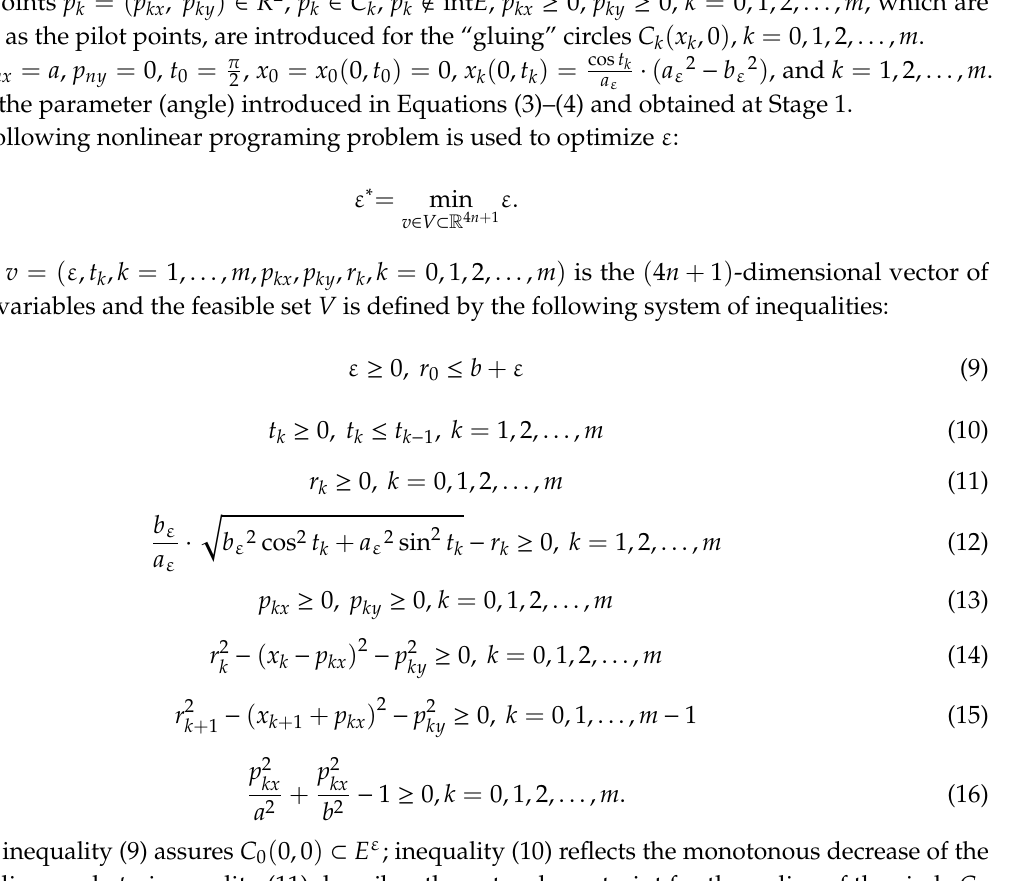
Figure 4. Illustration of Stage 2 .